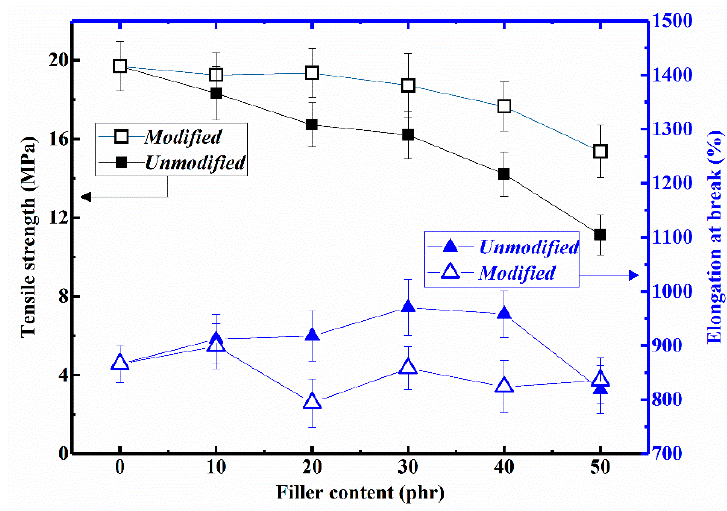
Figure 7. The influence of filler content on the tensile strength and elongation at break of the FD/NR and mFD/NR composites.